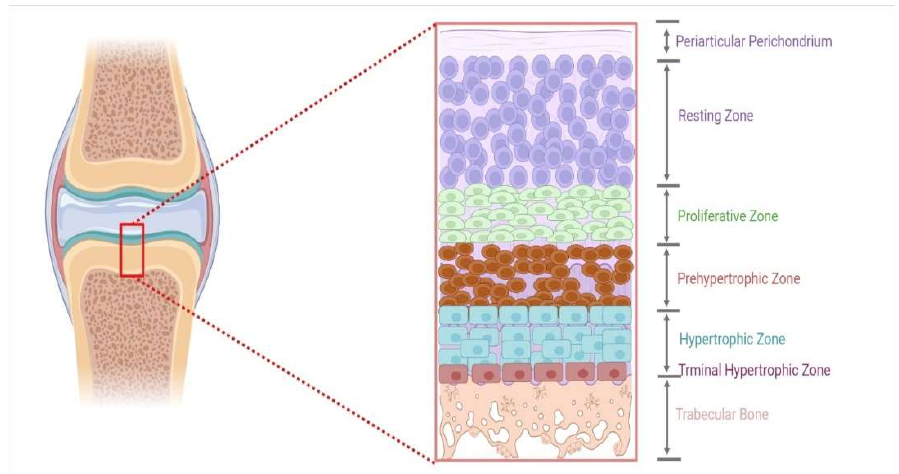
Figure 1. An illustration of a growth plate’s different